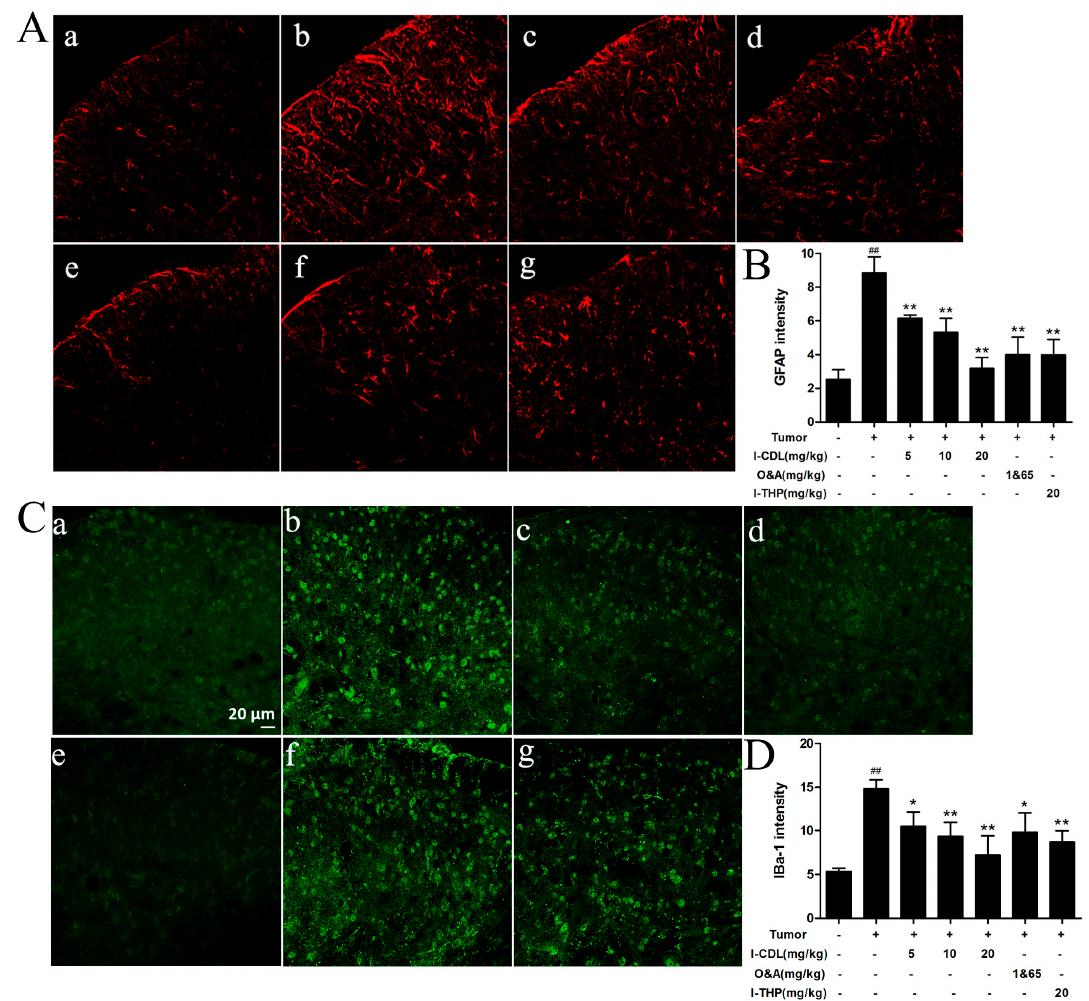
Figure 4. Effect of l -CDL on glial cells activation in the spinal cord. ( A ) The expression of GFAP in spinal dorsal horn; ( B ) Graph showing the mean fluorescence intensity for GFAP; ( C ) The expression of IBA-1 in spinal dorsal horn; ( D ) Graph showing the mean fluorescence intensity for IBA-1. ( a ) Sham group; ( b ) Tumor group; ( c ) l -CDL 5 mg/kg group; ( d ) l -CDL 10 mg/kg group; ( e ) l -CDL 20 mg/kg group; ( f ) O&A 1&65 m/kg group ( g ) l -THP 20 mg/kg group; ## p < 0.01 vs. the sham group; * p < 0.05, ** p < 0.01 vs. the tumor group. Scale bar = 20 μ m (mean ± S.D., n = 3).